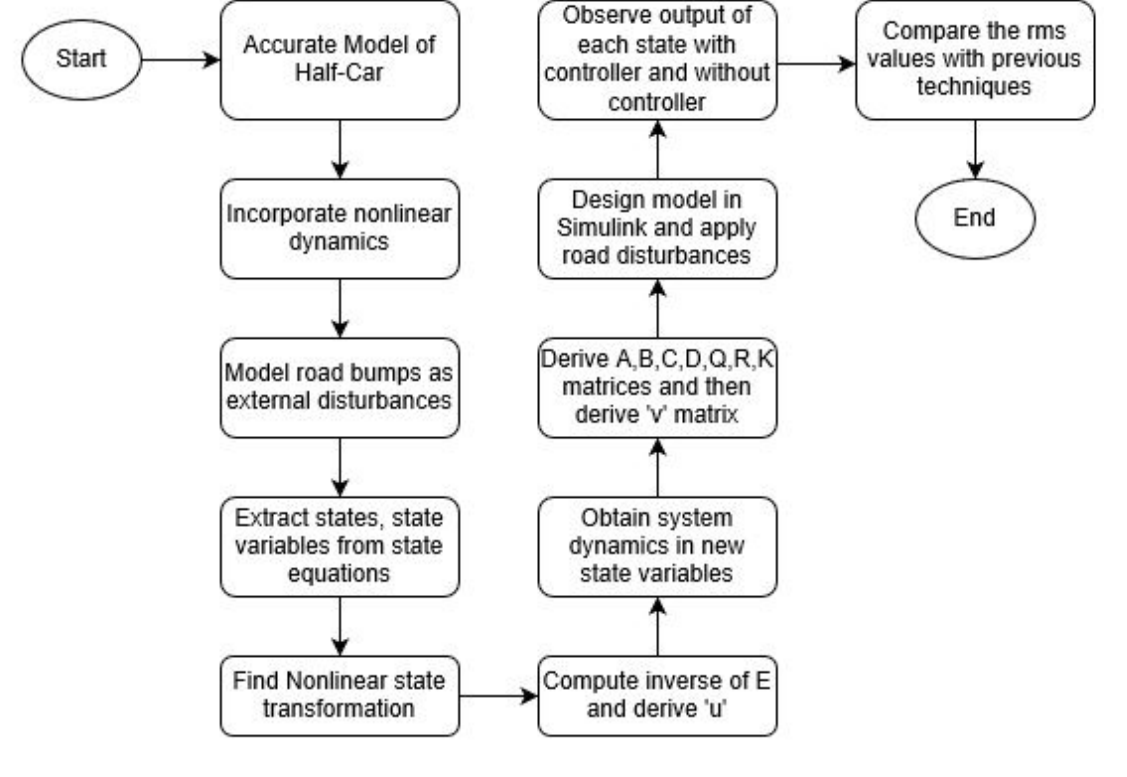
Figure 1. Flowchart of